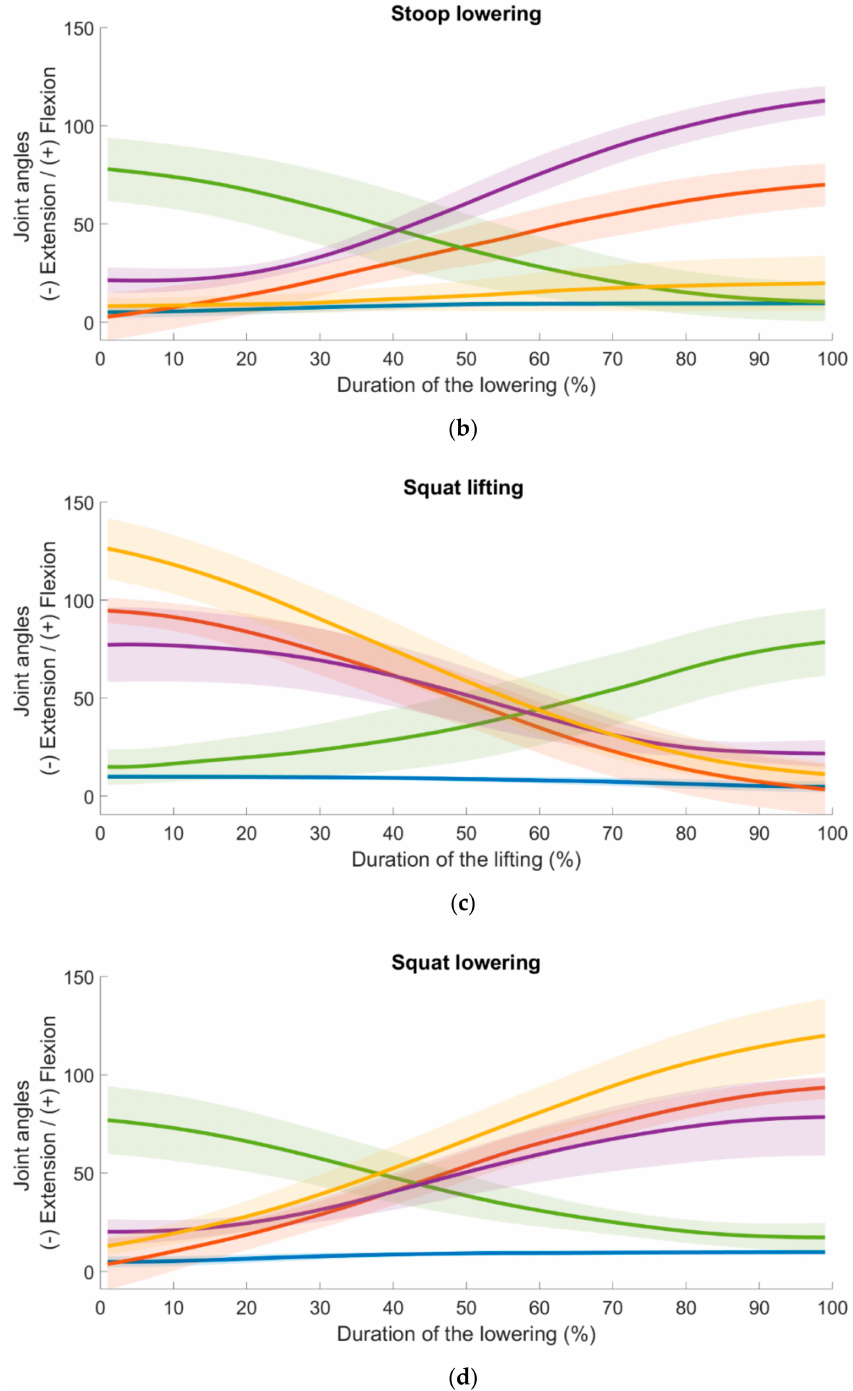
Figure A1. Kinematics of the five di ff erent joints (L5S1 (blue), hip (red), knee (yellow), shoulder (purple) and elbow (green) during the two di ff erent lifting techniques (stoop and squat) with a load equal to 40% ALST. Shaded areas indicate standard deviations. ( a ) Joint angles during stoop lifting; ( b ) joint angles during stoop lowering; ( c ) joint angles during squat lifting; ( d ) joint angles during squat